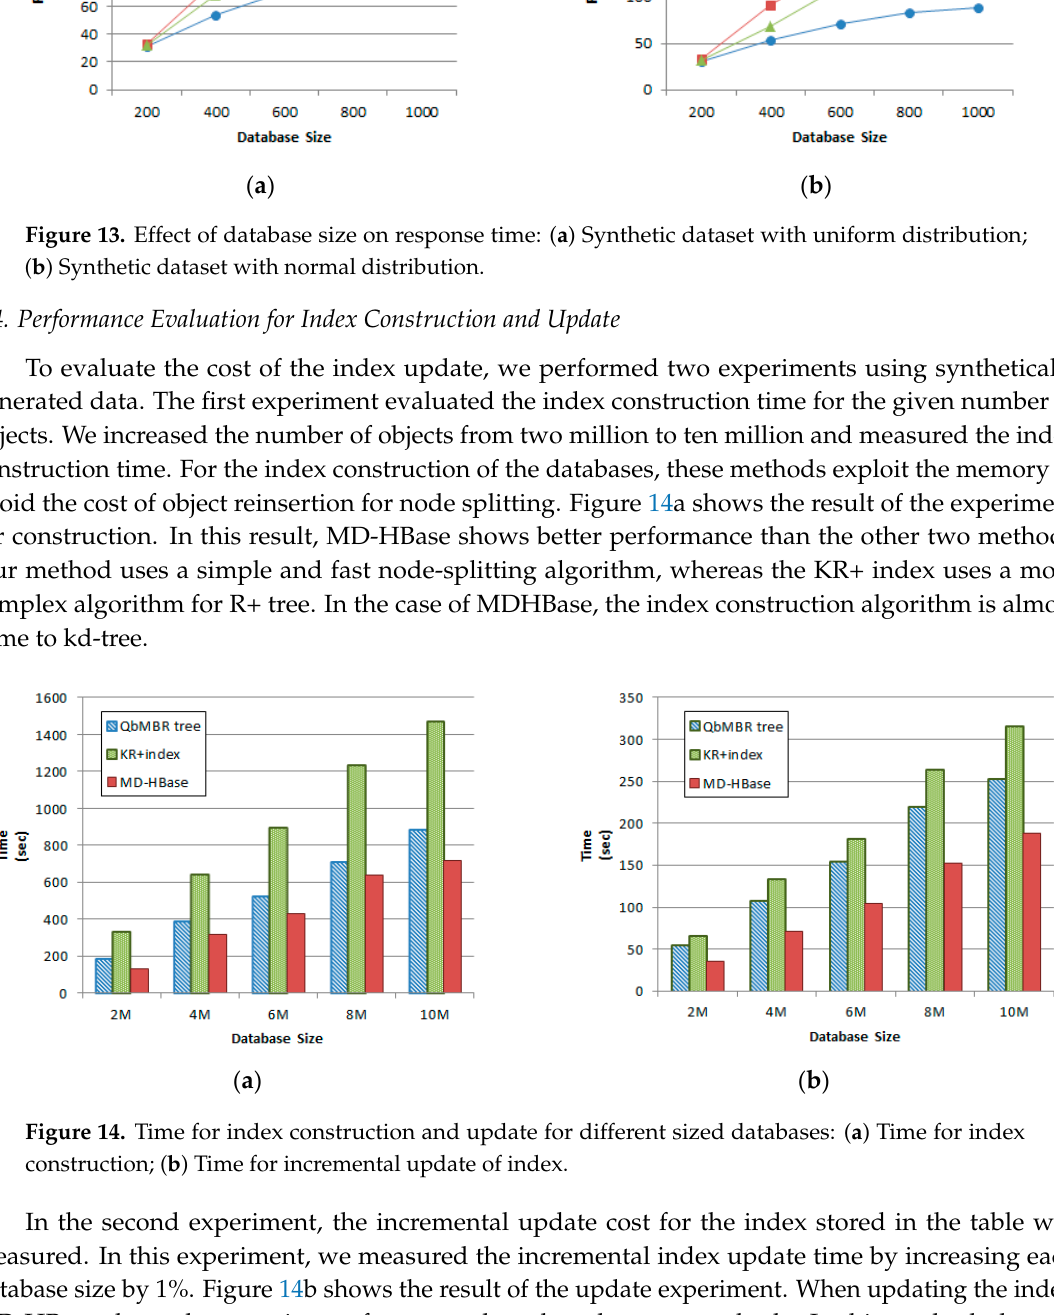
Figure 13. Effect of database size on response time: ( a ) Synthetic dataset with uniform distribution; ( b ) Synthetic dataset with normal distribution.